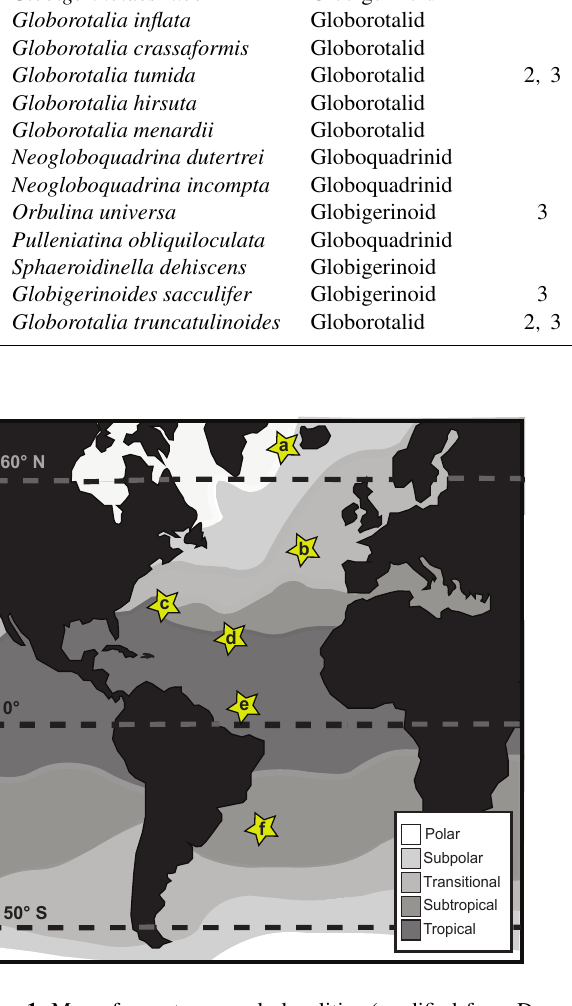
(Fig. S1). Three-dimensional measurements included multi- ple estimates of volume and surface area using the top (i.e., visible) half and a combination of visible top halves with hy- pothetical backsides (see Hsiang et al., 2016; Fig.